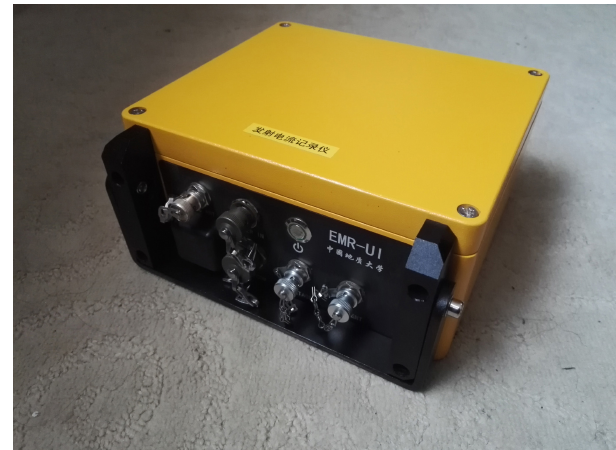
Figure 3. Photograph of the data acquisition unit.